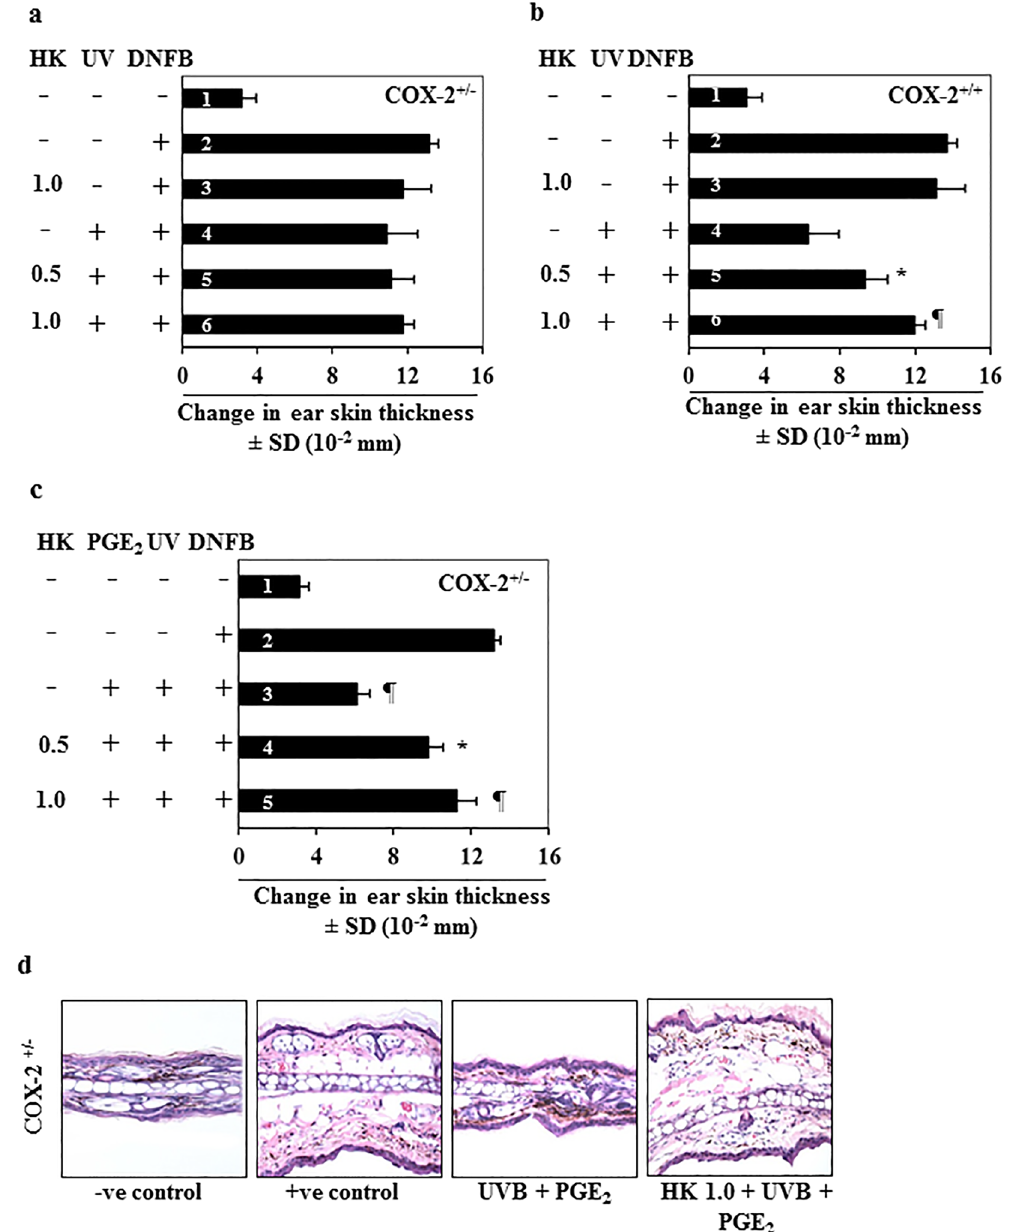
Figure 2. Honokiol does not inhibit UVB-induced suppression of CHS response in COX-2-deficient mice. COX-2-deficient mice were treated and analyzed as described in Fig. 1(a and b ) . Topical application of honokiol does not prevent UVB-induced suppression of CHS response in COX-2-deficient mice. COX-2- deficient mice were resistant to UVB-induced suppression of the CHS response. ( b ) The wild-type littermates of COX-2-deficient mice show UVB-induced suppression of CHS, and topical application of honokiol inhibits UVB-induced suppression of CHS in these mice. Significant suppression of the CHS response versus UVB exposure in the absence of honokiol treatment. * P < 0.01, ¶ P < 0.001. ( c ) Topical treatment of PGE 2 after each UVB exposure promotes suppression of CHS in UVB-exposed COX-2-deficient mice (3 rd bar), and topical application of the mice with honokiol prior to the UVB exposure (4 th and 5 th bar) stimulates the CHS response in the PGE 2 treated and UVB-irradiated COX-2-deficient mice. Significant suppression of CHS (3 rd bar) versus positive control group (2 rd bar), ¶ P < 0.001. Significant restoration of CHS response by honokiol versus PGE 2 induced suppression of CHS, * P < 0.01, ¶ P < 0.001. ( d ) Histologic (H&E staining) evaluation of ear skin sections obtained from COX-2-deficient (COX-2 + / − ) mice with and without treatment with PGE 2 and honokiol and subjected to the CHS protocol. Topical administration of PGE 2 to UVB-exposed COX-2-deficient mice resulted in reduced ear skin thickness as compared to the positive ( + ve) control group of mice that were sensitized with DNFB, while topical application of honokiol prior to UVB + PGE 2 treatment enhanced the thickness of the ear skin and infiltration of leukocytes in the ear skin. Representative micrographs are shown from mice, n =